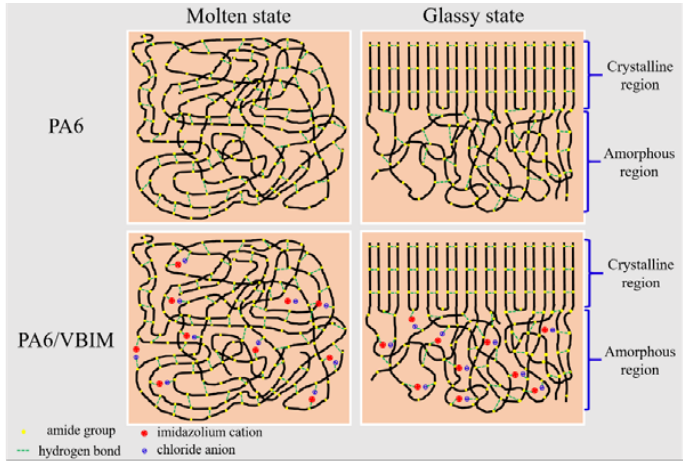
Figure 11. A schematic of the interactions between PA6 and VBIM under molten and glassy states.